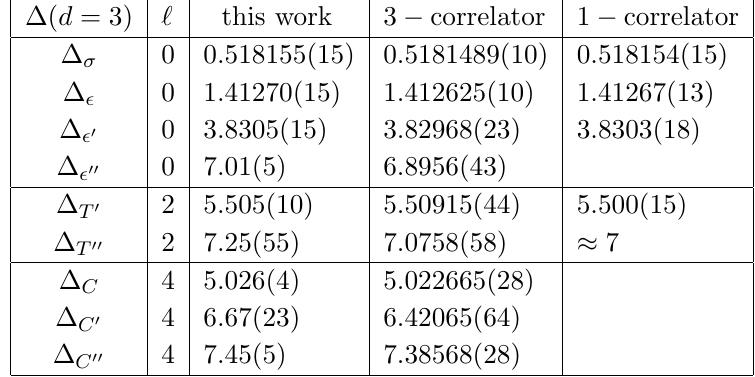
Table 1 . Comparison of d = 3 conformal dimensions of low-lying (cid:12)elds with earlier results of one-correlator [12] and three-correlator [13]